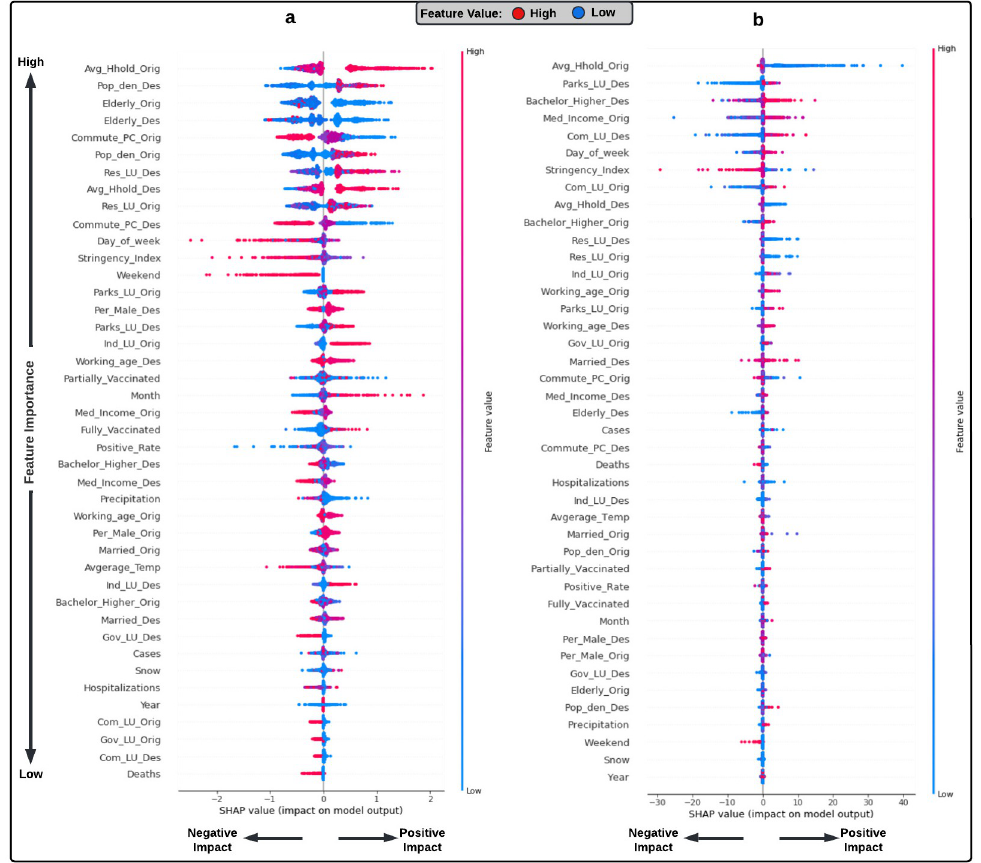
Fig 6. SHAP summary plot for the direct demand model in (a) Innisfil and (b) Chicago.